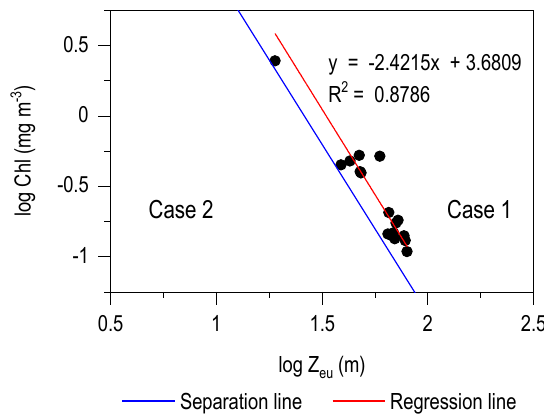
Figure 3. Relationship between the depth of the euphotic zone (z eu ) and mean concentration of Chl in the same layer. Case 1 / Case 2 separation line [46] and data regression line are reported.